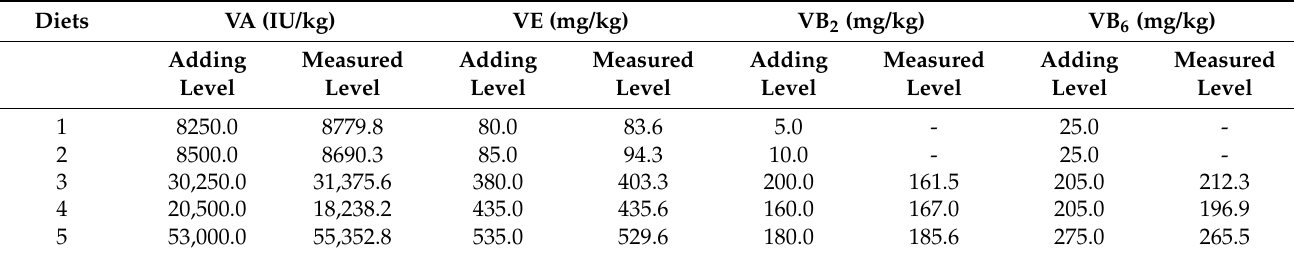
Table 1. Vitamins content in the diets before condition (air-dry